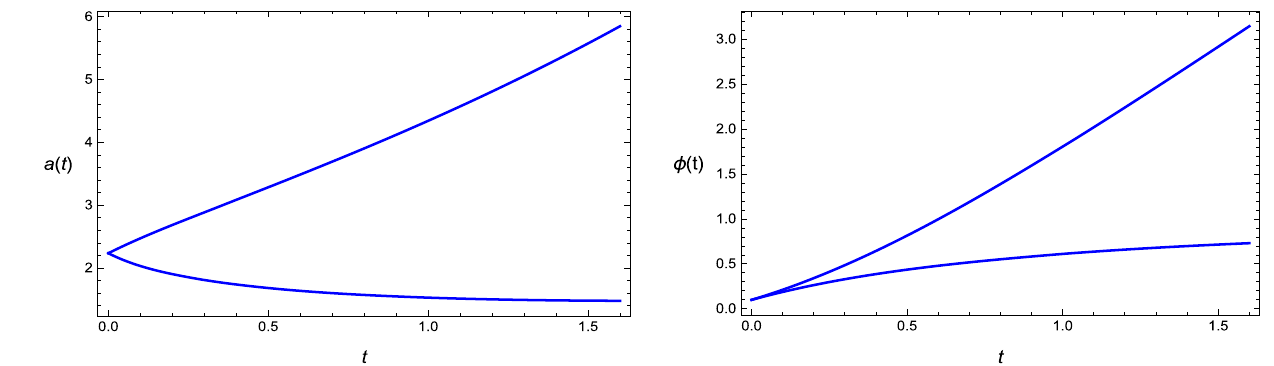
Fig. 3 Evolution of scale factor and canonical scalar field ( (cid:7) = 1) for f ( R ,ϕ,χ) = ϕ R + h (χ) with h (χ) = k 1 χ + k